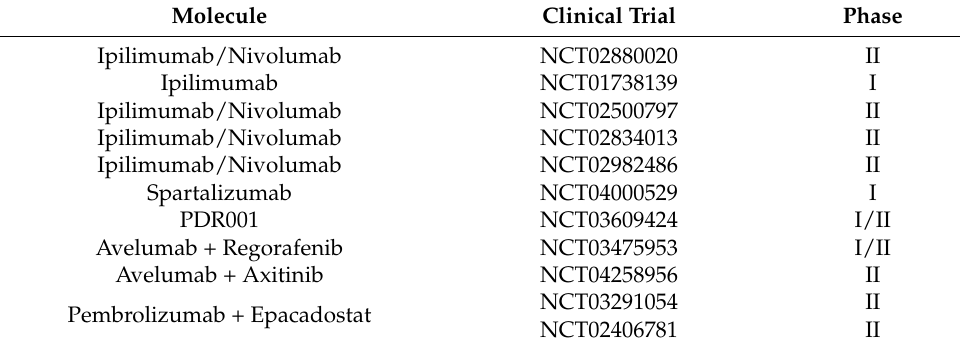
Table 7. Immunotherapeutic Agents in ongoing clinical